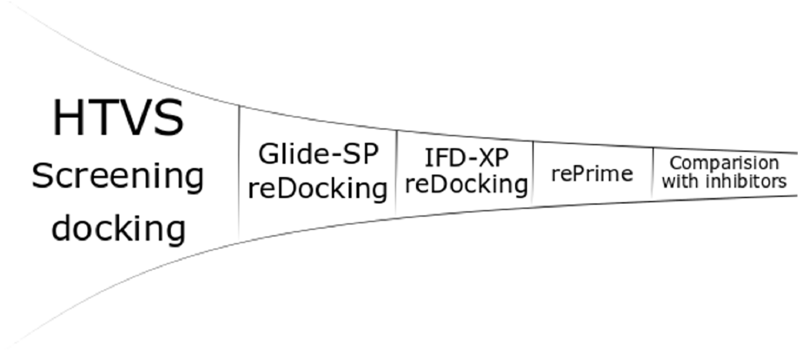
Figure 2. Generalized docking scheme. HVTS, high throughput virtual screening; SP, standard precision; IFD, induced fit docking; XP, extra precision.